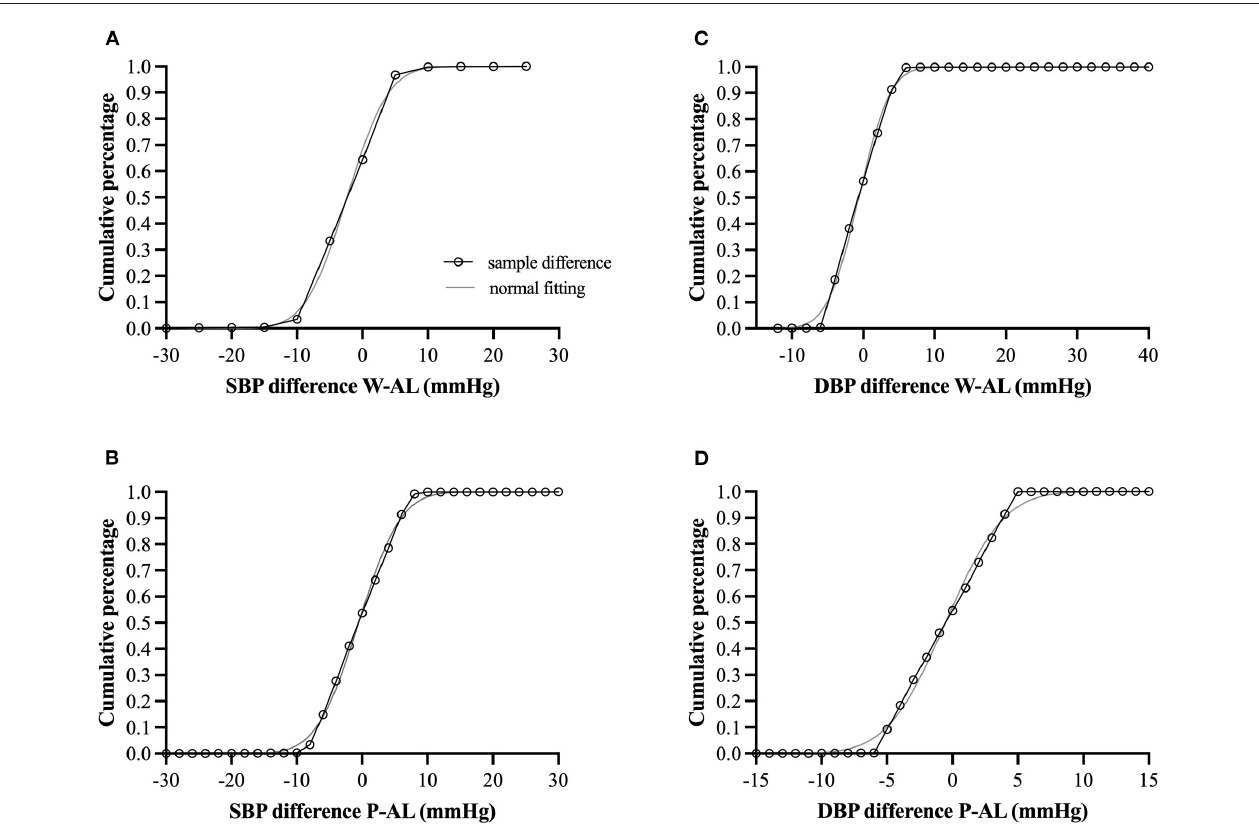
FIGURE 4 | (A–D) Cumulative percentage difference (open circles connected with black solid line) for the observed absolute differences between arterial line (AL) and the photoplethysmography-based sensors with corresponding hypothesized normal cumulative distribution (gray solid line). W, wristwatch configuration; P, chest-patch configuration; DBP, diastolic blood pressure; SBP, diastolic blood pressure; AL, arterial line. For all comparisons, the goodness of fit (R2) was > 0.99 for both SBP and DBP.